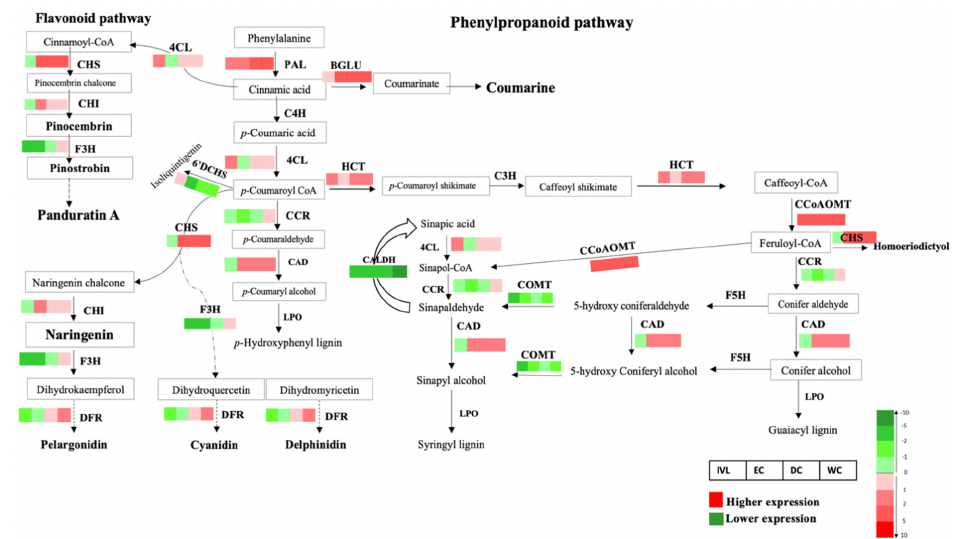
Figure 5. Scheme of the flavonoid and phenylpropanoid biosynthetic pathways in B. rotunda based on KEGG pathways. Genes encoding enzymes for each step are indicated as follows: CAD, cinnamyl alcohol dehydrogenase; BGLU, Beta-glucosidase; CALDH, coniferyl-aldehyde dehydrogenase; C4H, cinnamic acid 4-hydroxylase; 4CL, 4-coumarate–CoA ligase; CHS, chalcone synthase; CHI, chalcone isomerase; CCoAOMT, caffeoyl-CoA 3-O-methyltransferase; C3H, ρ -coumarate 3-hydroxylase; CCR, cinnamoyl-CoA reductase; COMT, caffeic acid O-methyltransferase; 6’DCHS, 6 ′ -deoxychalcone synthase; DFR, dihydroflavonol 4-reductase; F3H, flavonoid 3-hydroxylase; F5H, ferulate 5-hydroxylase; HCT, Hydroxycinnamoyl-CoA shikimate; LPO, Lactoperoxidase; PAL, phenylalanine ammonia lyase. Beside each enzyme, four boxes are shown (from left to right): in vitro leaf (IVL), embryogenic callus (EC), dry callus (DC) and watery callus (WC). Red boxes indicate relatively higher mRNA expression compared to the leaf sample with the highest levels in darker red. Green boxes indicate relatively lower expression compared to the leaf sample. The colour box is based on log2FC values.